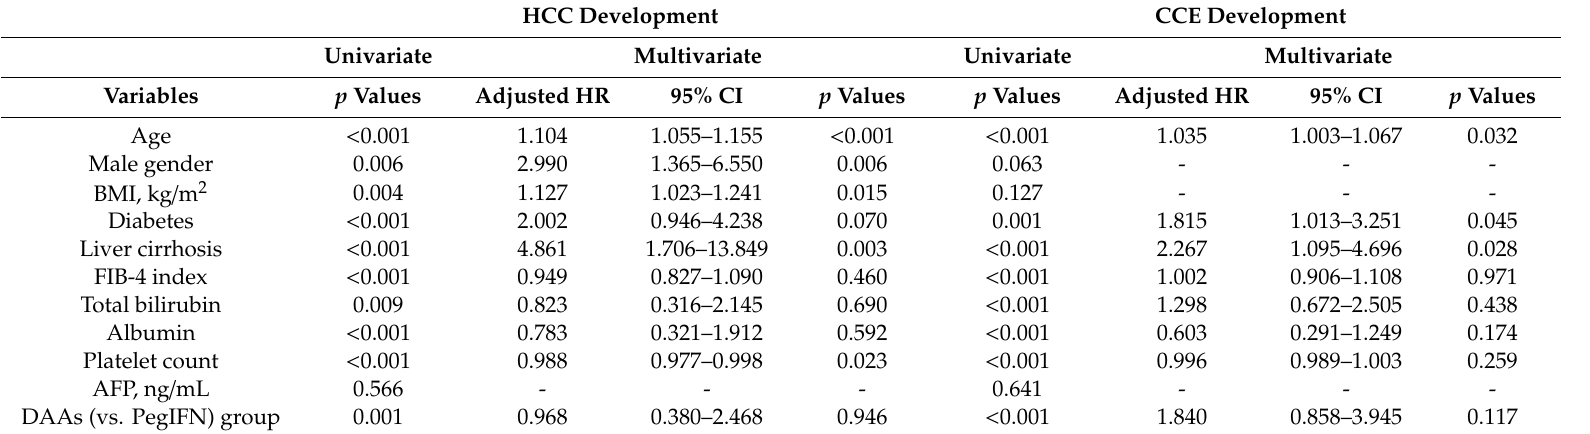
Table 3. Predictive factors for clinical outcomes (n =